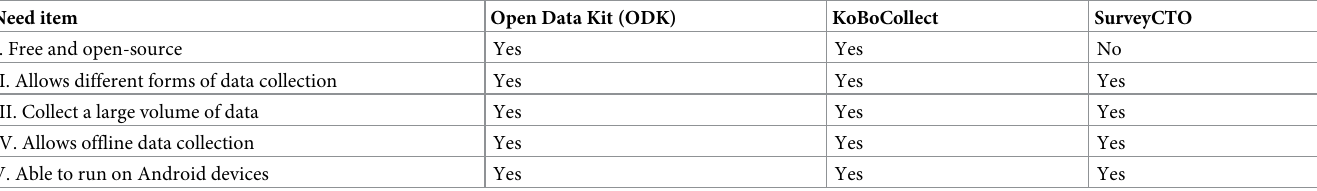
Table 2. Benchmark comparison of the three popular systems for data collection at that